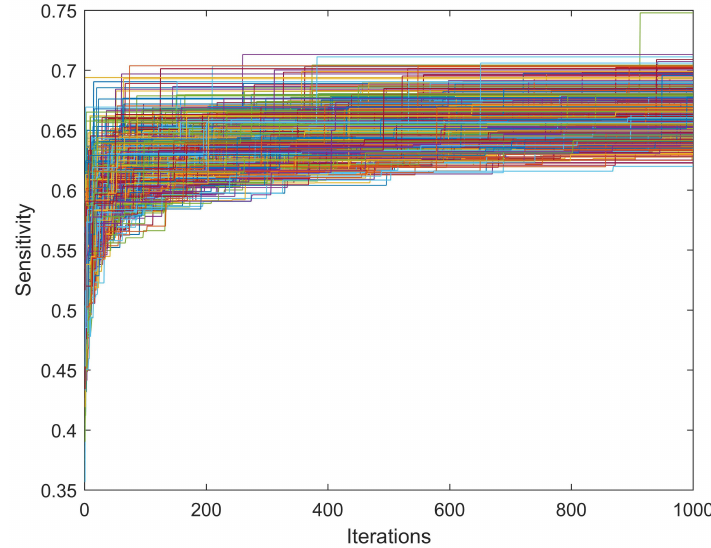
Figure 2. Sensitivity results of the